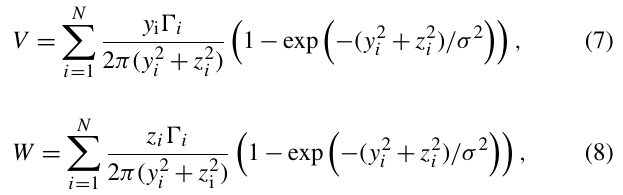
Figure 1. Diagram showing a collection of vortices shed from the rotor plane with the corresponding downstream distribution of span- wise velocities due to the superposition of the